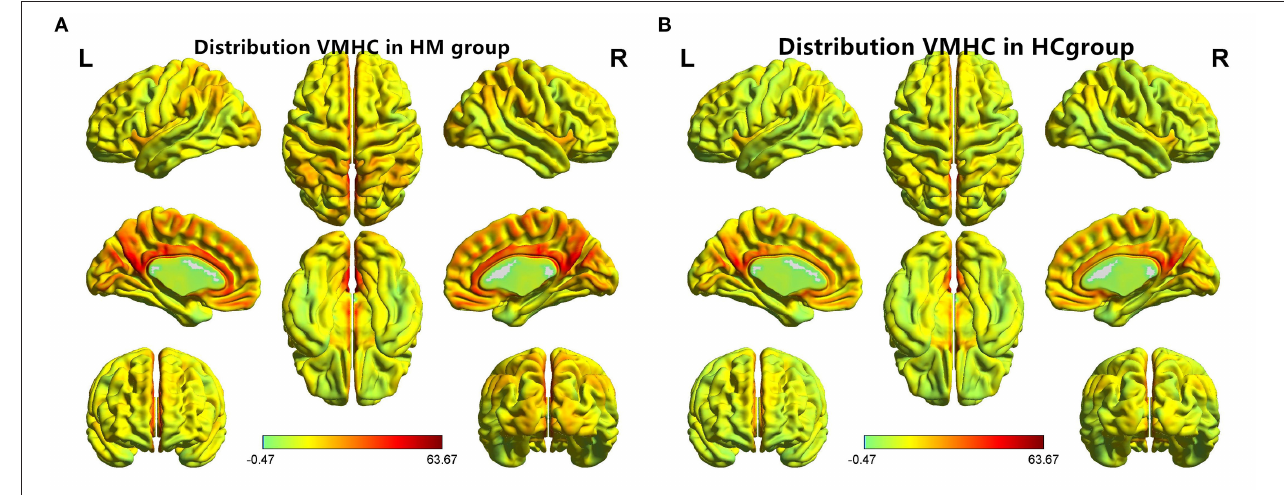
FIGURE 1 | Distribution patterns of VMHC were observed at the group level in patients with (A) HM and (B) HCs. VMHC, voxel-mirrored homotopic connectivity; HM, high myopia; HCs, healthy controls.